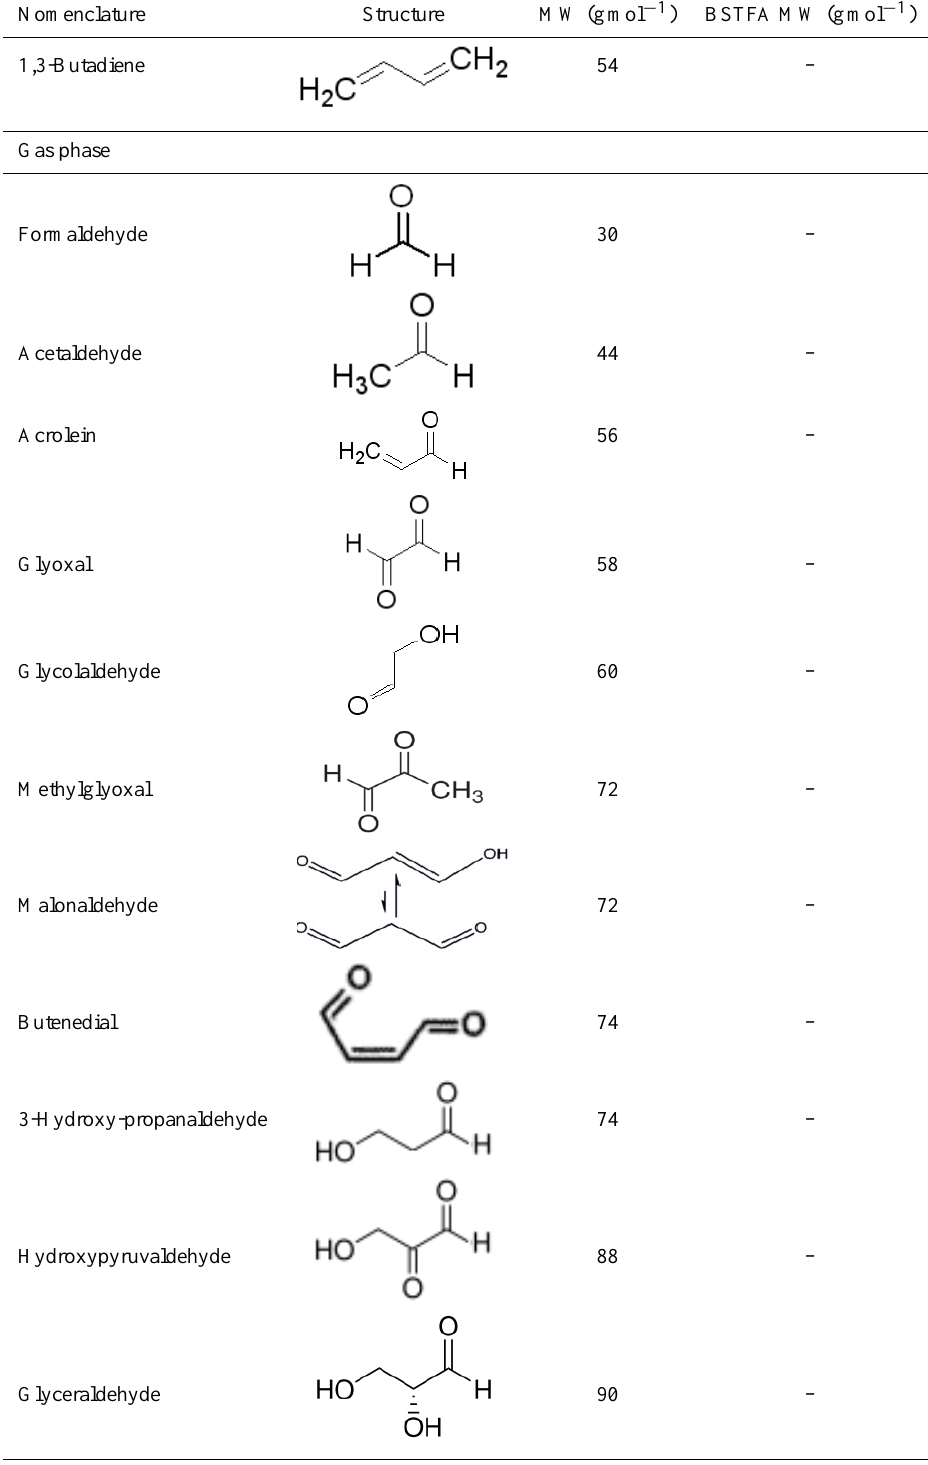
Table 2. Summary of gas-phase and SOA products generated from the oxidation of 1,3- butadiene. 2 Nomenclature